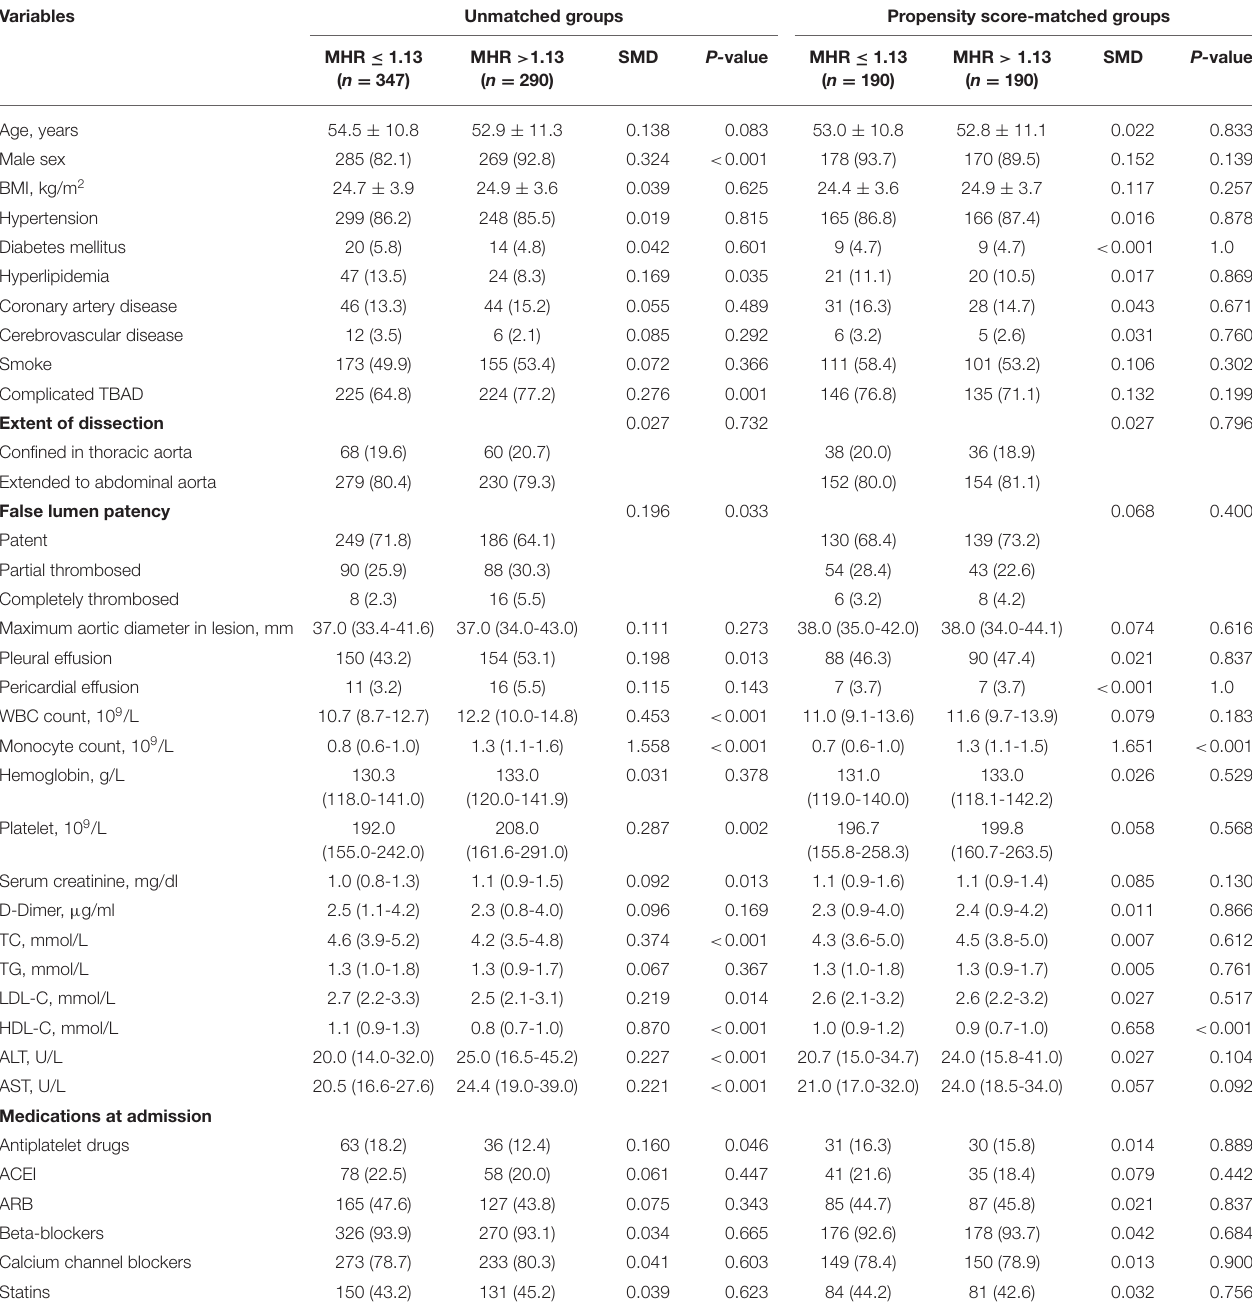
TABLE 1 | Baseline characteristics stratified by preoperative monocyte to high-density lipoprotein ratio (MHR) before and after propensity score matching.